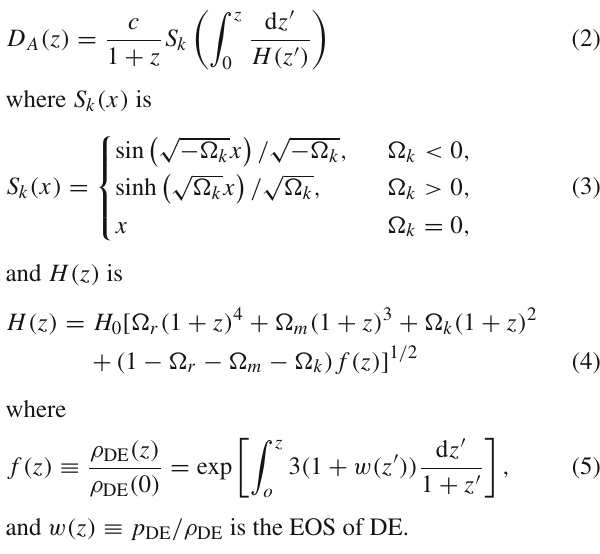
tour plot. also plot the evolution of the normalized Hubble parameter H ( z ) in Fig. 2 where the Hubble parameter is normalized by comparing with those in the best-fit (cid:2) CDM